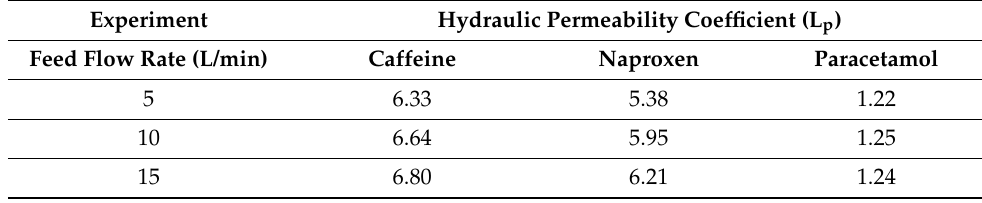
Figure 7. Effect of feed flow rate on the rejection efficiency of ( a ) caffeine, ( b ) naproxen and ( c ) paracetamol. Table 4. Hydraulic coefficients of the AFC 40 and AFC 80 membranes obtained at different feed flow rates during PhAC